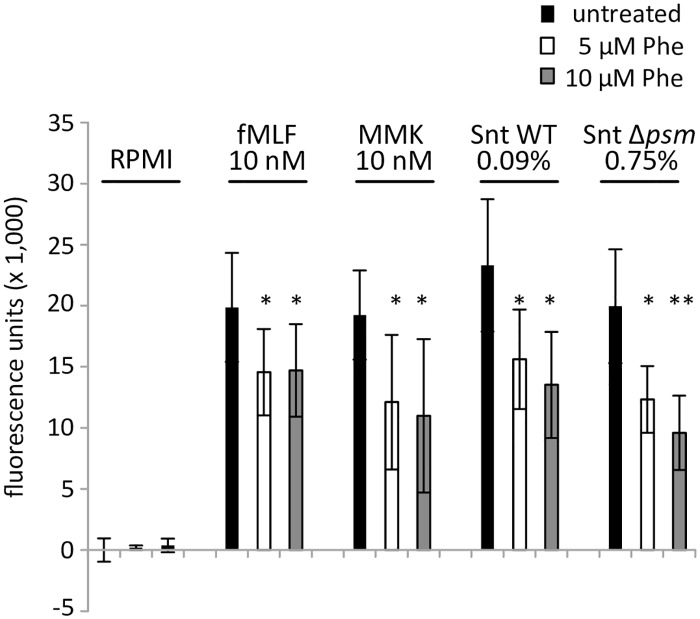
Phevalin inhibits activation of primary human neutrophils.Addition of synthetic phevalin inhibits activation of primary human neutrophils. By loading PMN with the calcium-sensitive fluorophore Fluo3 and flow cytometry we determined calcium flux upon addition of external stimuli as a proxy for PMN activation. Pre-incubation of PMN with 5 or 10 μM phevalin led to a significant decrease of calcium flux when PMN were stimulated with fMLF, MMK, or dilutions of culture supernatant of S. aureus wild type (0.09%) or a mutant in PSMs (USA300Δαβδ; 0.75%). Depicted is Fluo3 fluorescence units with RPMI-treated PMN set to 0.